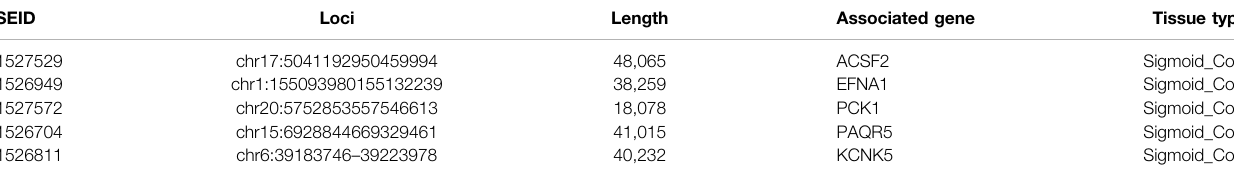
TABLE 2 | Information of potential pathogenic super-enhancers in IBD.